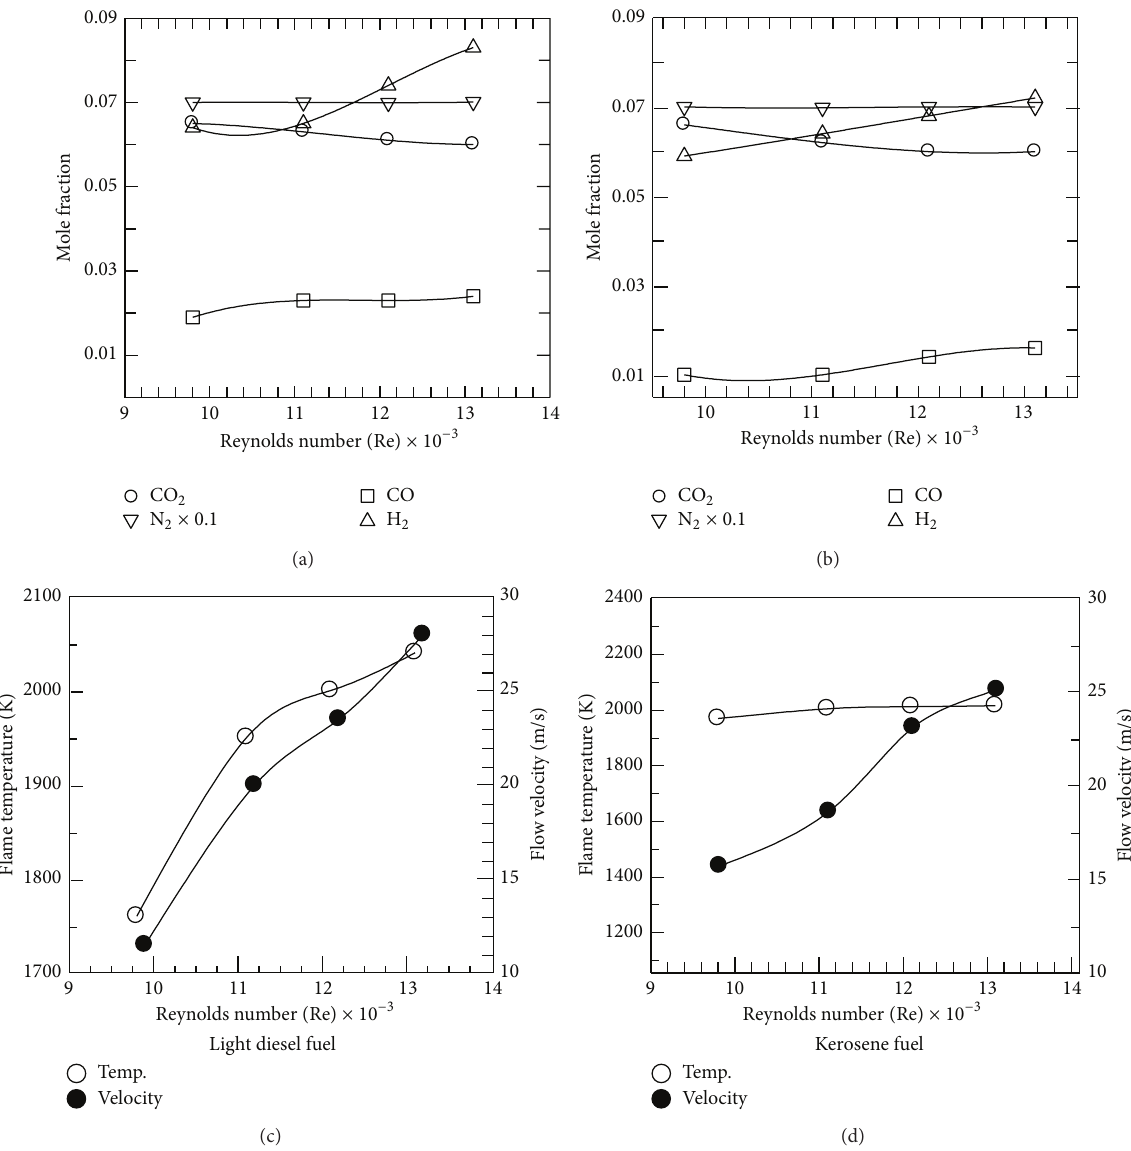
Figure 8: Effect of Reynolds number on flame structure for turbulent premixed air flame at residence time 5.4 ms, solidity ratio 0.68, and pressure